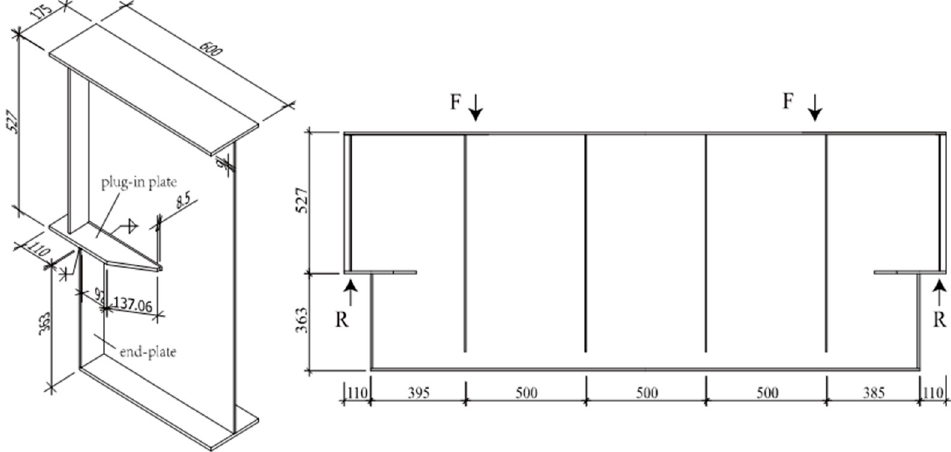
Figure 12. Cracks originated at the weld toe on the plug-in plate.